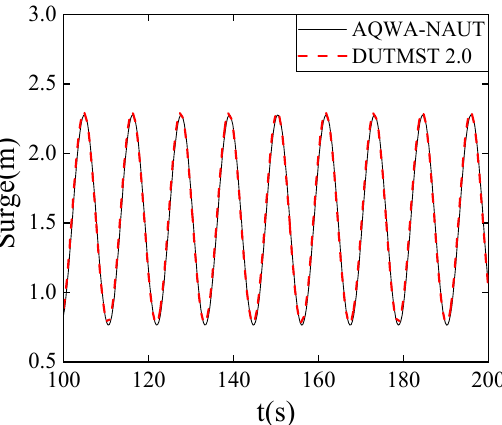
Figure 6. Surge response of the conventional TLP to the action of wave–current coupling.